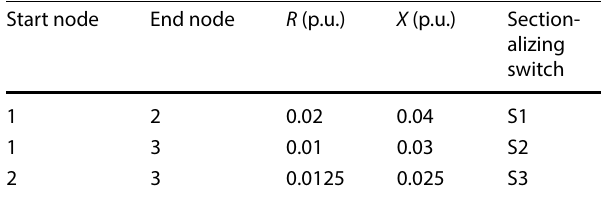
Table 11 The 3-node test system line data